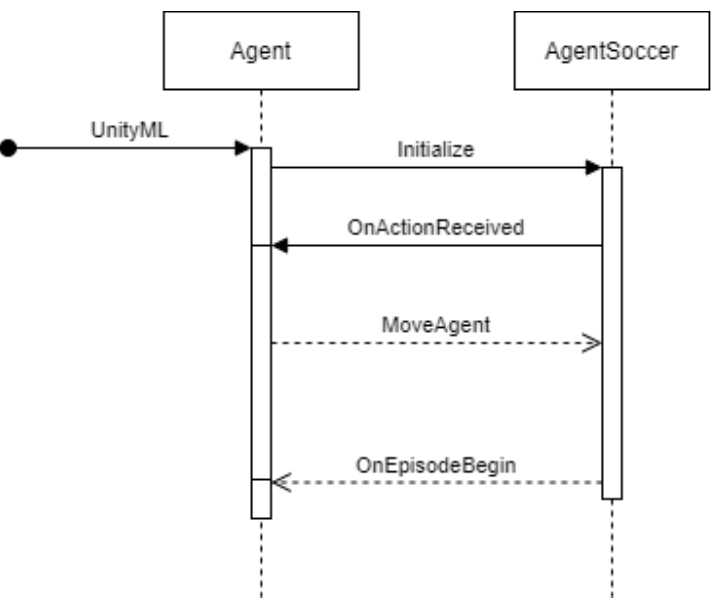
Figure 9. Futsal game-sequence diagram.